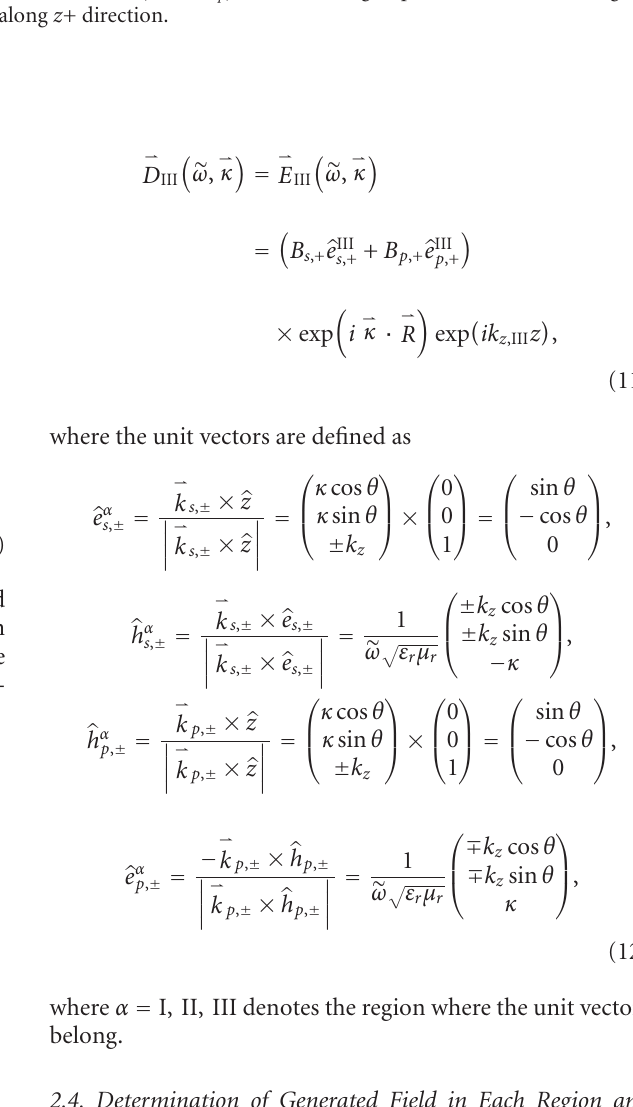
(cid:2) (cid:2) B s , − and B p , − denote the eigen-plane-wave modes in region I, and (cid:2) B 1, g , ± in region II denotes the first eigenmode generated from (cid:2) B 1, b , ± in region II expresses the first eigenmode (cid:2) B 2, b , ± gives the second eigenmode bouncing back at the upper and lower boundaries (cid:2) (cid:2) B s ,+ and B p ,+ denote the eigen-plane wave modes in region